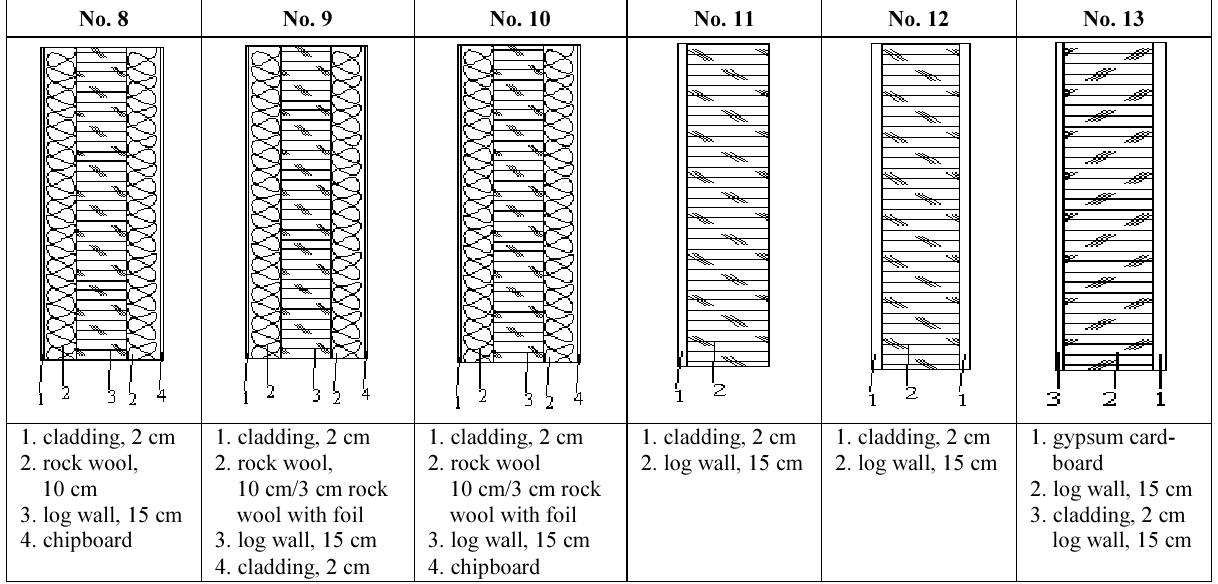
Fig. 8. Structures of experimental specimens of the log wall